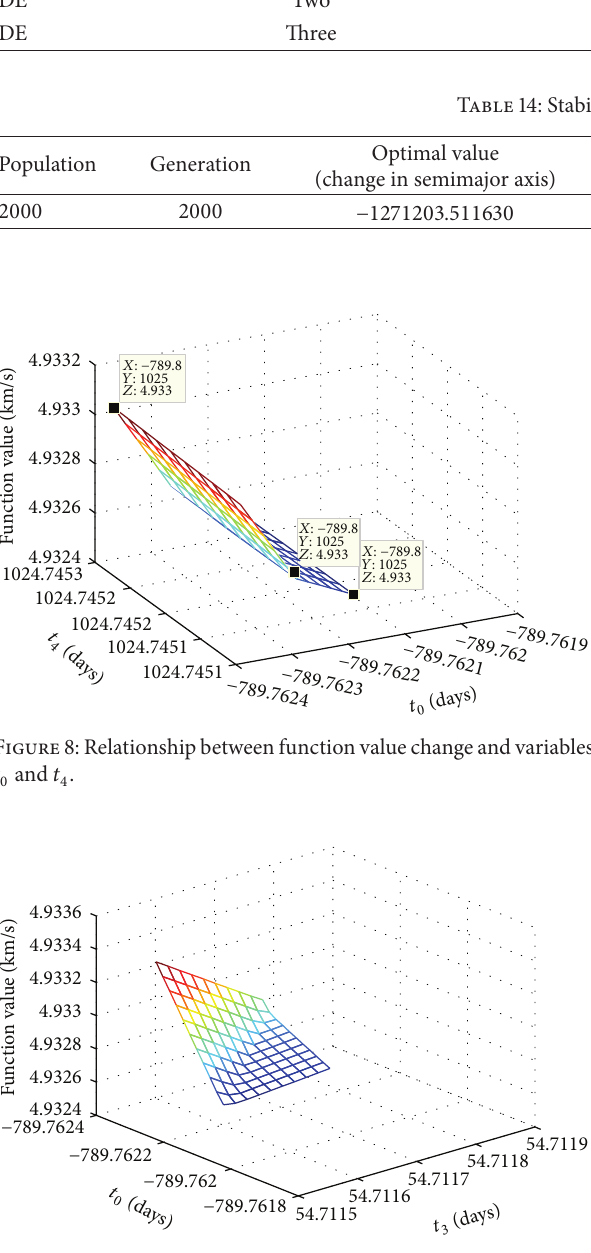
Figure 9: Relationship between function value change and variables 𝑡 𝑡 0 and 3